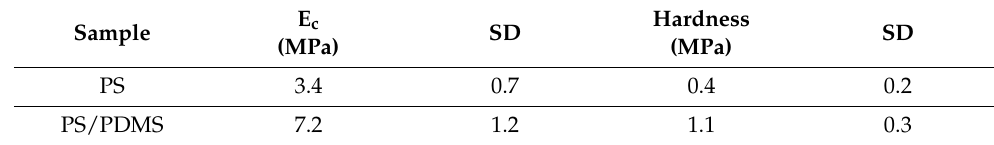
Table 3. The reduced Young’s modulus E c and the hardness of the electrospun fibers.